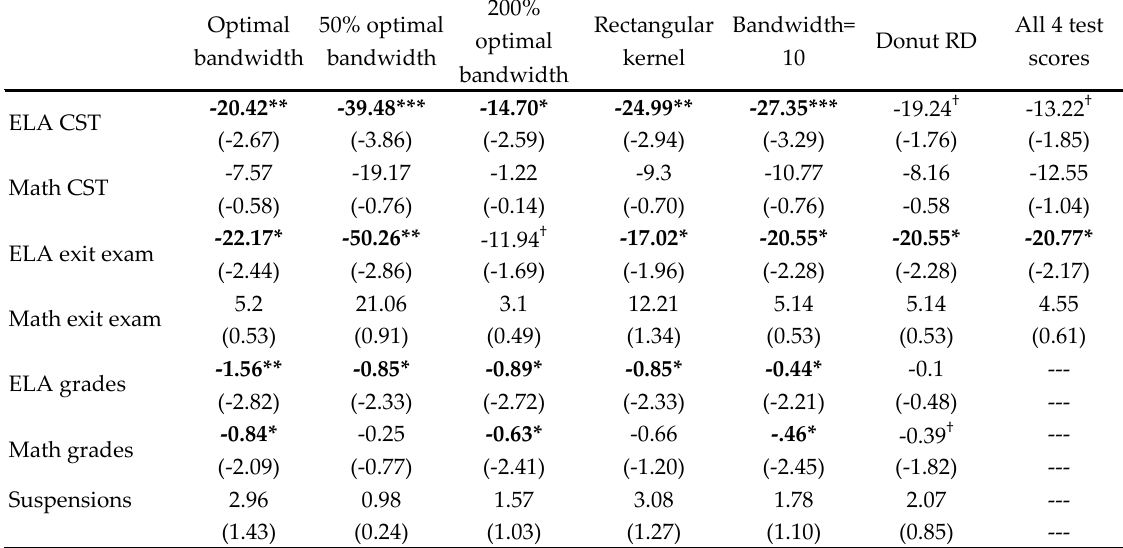
Table S6: Alternate specifications for regression discontinuity estimates of the effects of white vs. gold ID assignment on student achievement and behavior, 2011-12 Live Oak and Mann